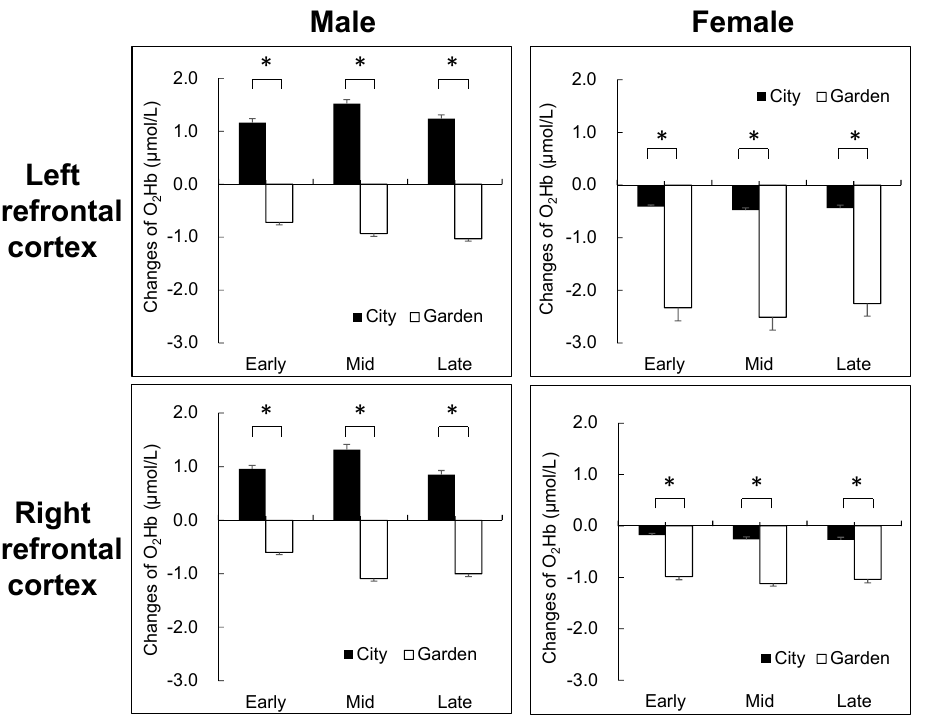
Figure 3. Comparison of oxy-hemoglobin (O 2 Hb) concentrations between male and female participants when observing city and garden landscapes in early, mid, and late sessions. Mean ± standard error; Male N = 9; Female N = 9; * p < 0.05.